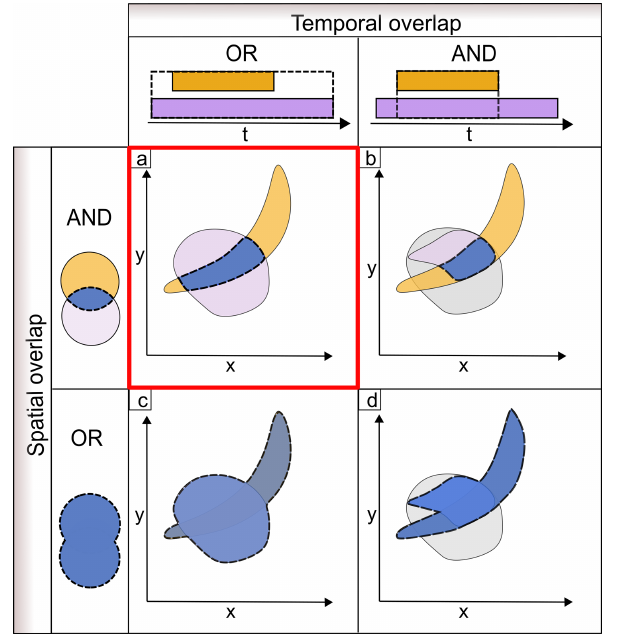
Figure 7. Different spatial and temporal scales considered in this study to define compound hazard events, with each case represent- ing a combination of spatial and temporal overlap. Panel (a) shows [spatial AND] with [temporal OR], (b) [spatial AND] with [tempo- ral AND], (c) [spatial OR] with [temporal OR], and (d) [spatial OR] with [temporal AND]. Hazard A is orange, hazard B is in purple, compound hazard is in blue, and parts of the footprints outside the temporal boundaries are grey. The definition retained for the rest of the study is highlighted with a red frame (a)